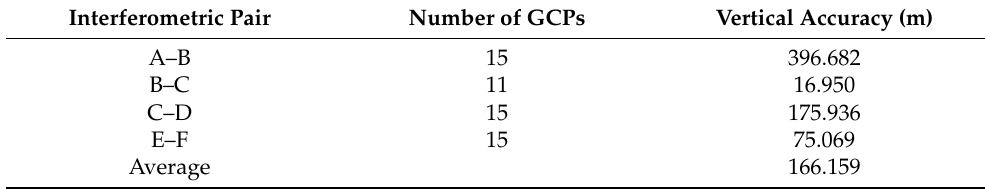
Table 5. Vertical accuracies of the interferometric results before the interferometric calibration process. Interferometric